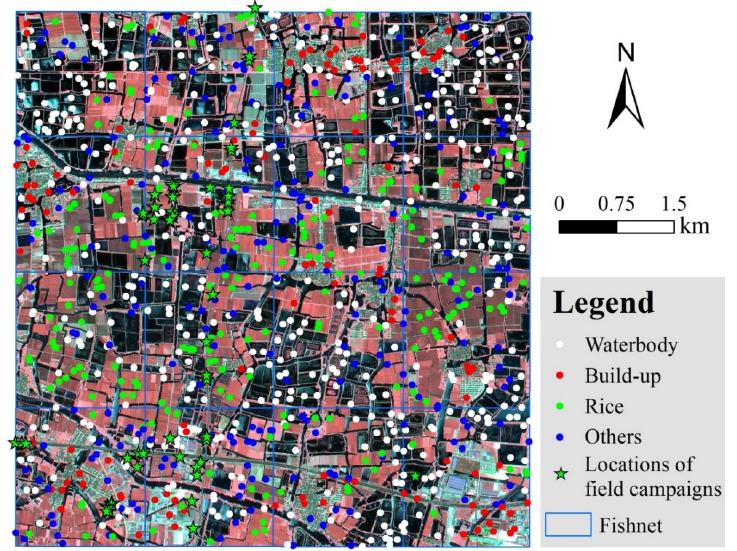
Figure 6. Location map of random sample points and field campaigns.